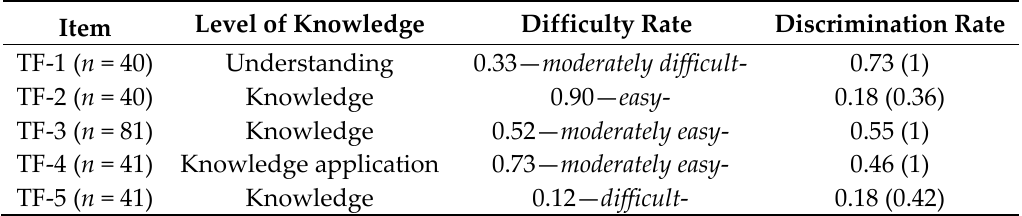
Table 4. Psychometric properties of the items of the multiple choice exam.